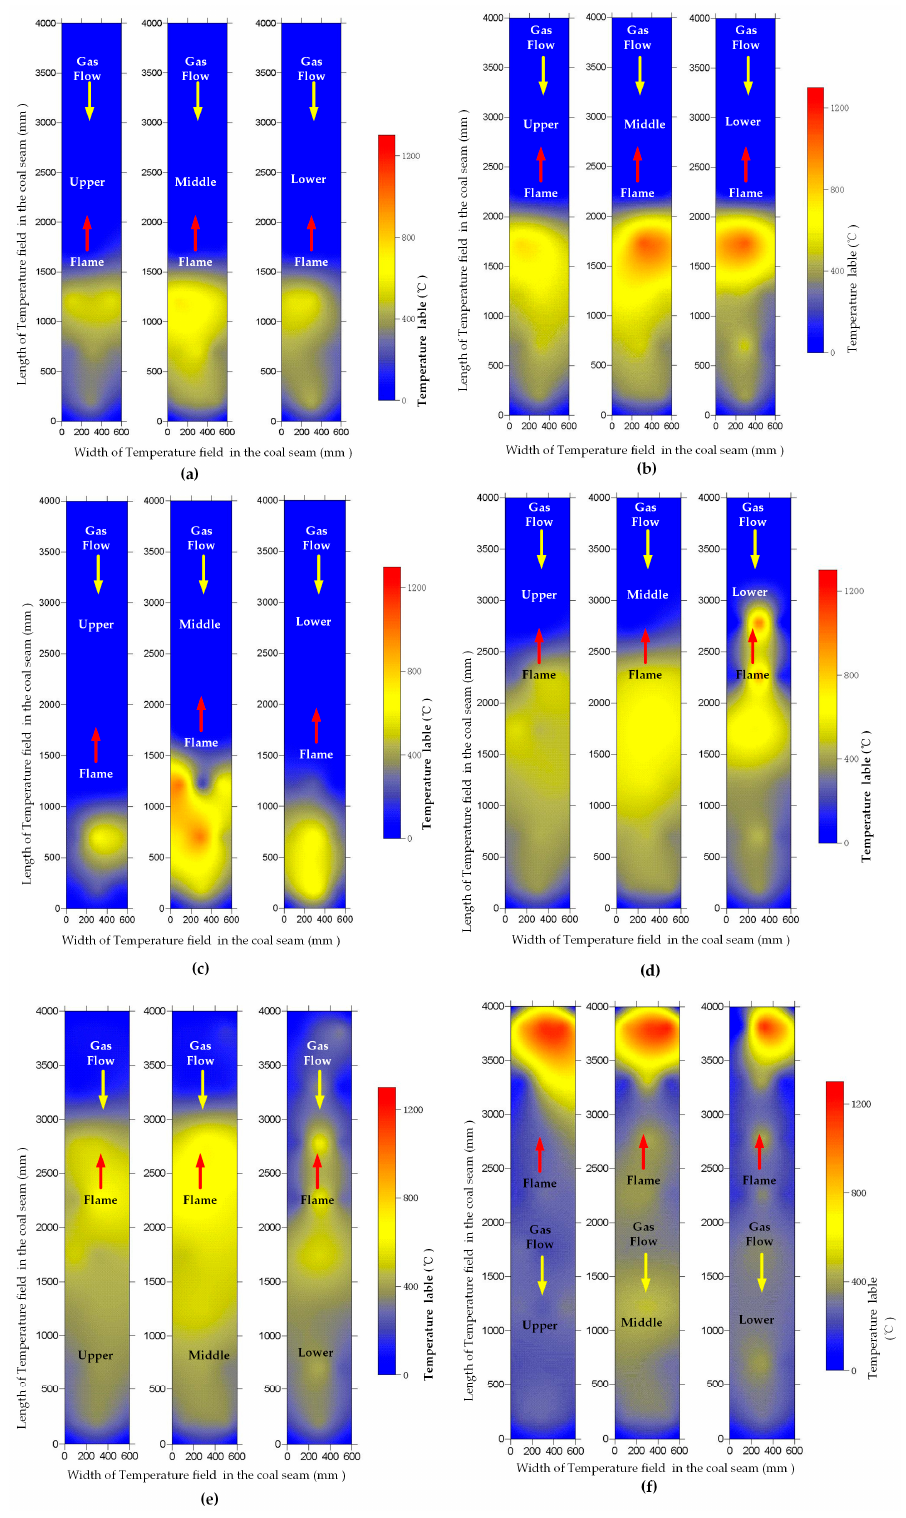
Figure 6. Changes in the temperature field during the reverse UCG process: with air as the gasifying agent at flow rates of ( a ) 10; ( b ) 15; and ( c ) 20 Nm 3 /h; with enriched oxygen as the gasifying agent at flow rates of ( d ) 10; ( e ) 15; and ( f ) 20 Nm 3